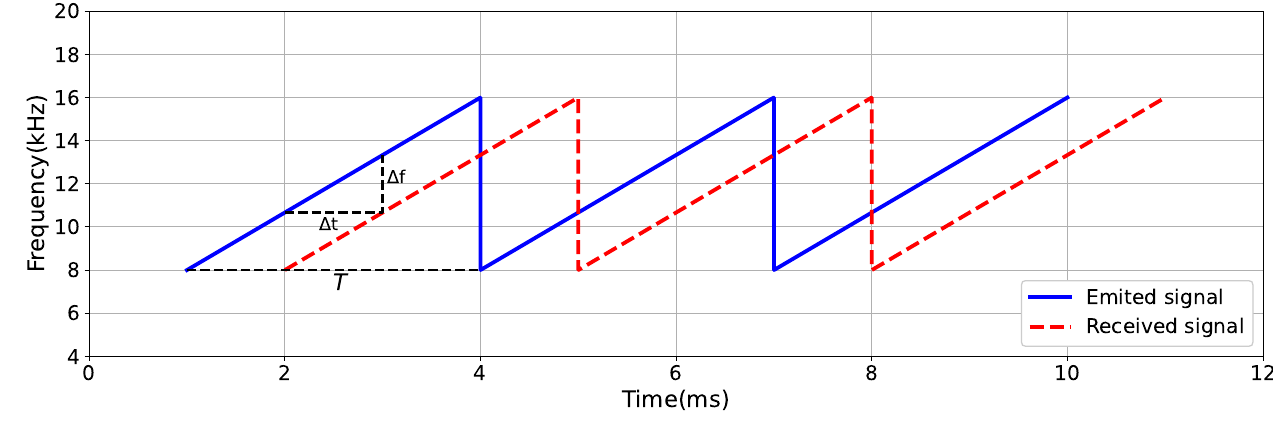
Figure 2. Emitted and received FMCW signals for distance calculation.